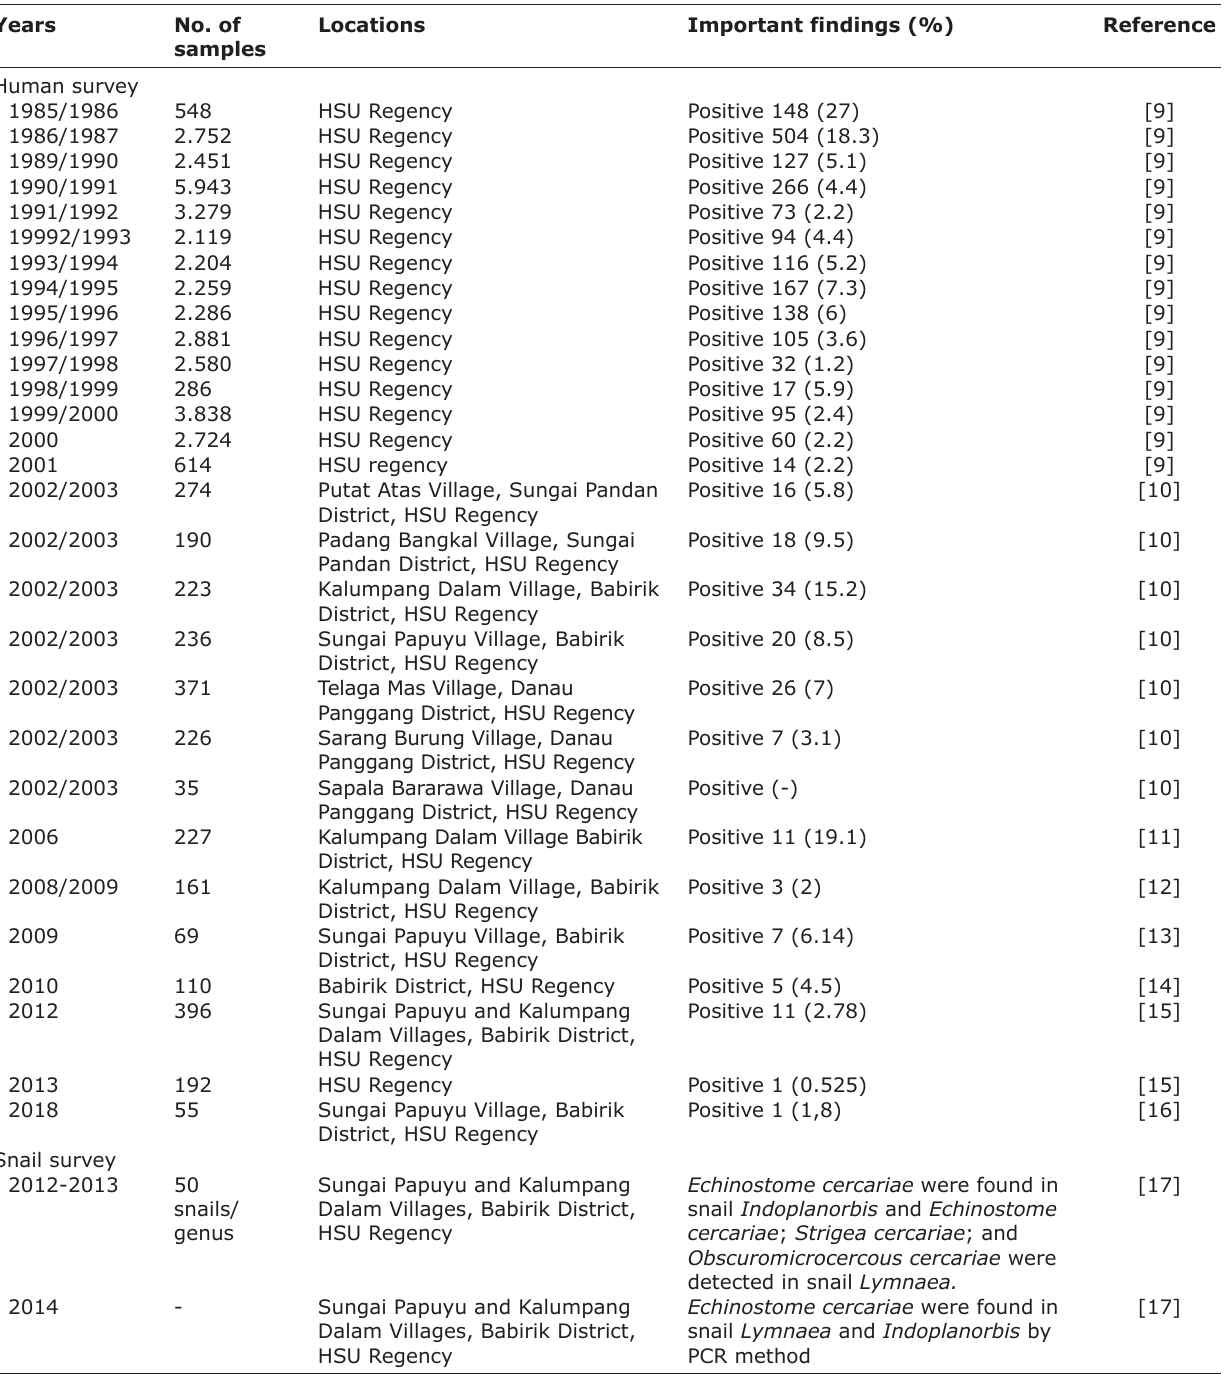
Table-1: Fasciolopsiasis survey in humans and snail in Indonesia between 1985 and 2018. Years No. of samples